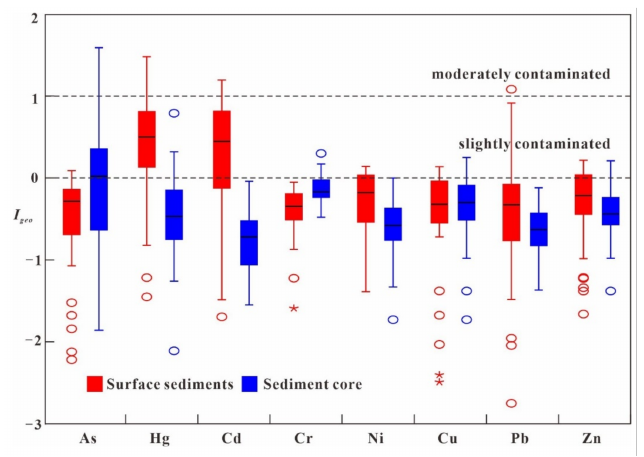
Figure 5. Box plot of I geo in the surface sediments and sediment core of Chagan